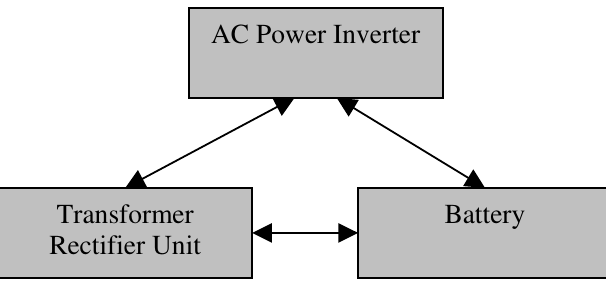
Fig 3. Mutual relationship of components of electric